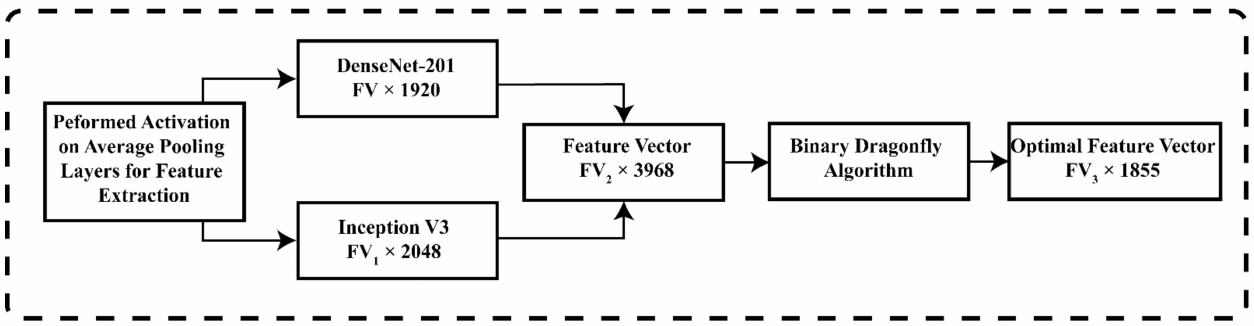
Figure 5. Proposed feature optimization